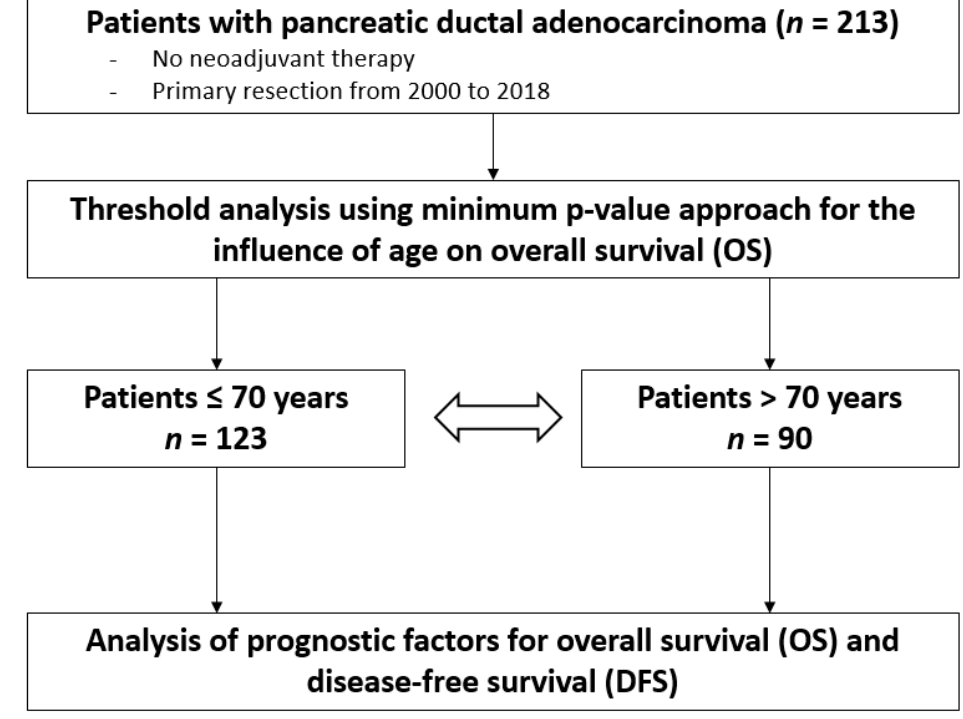
Figure 1. Flowchart of the study design.